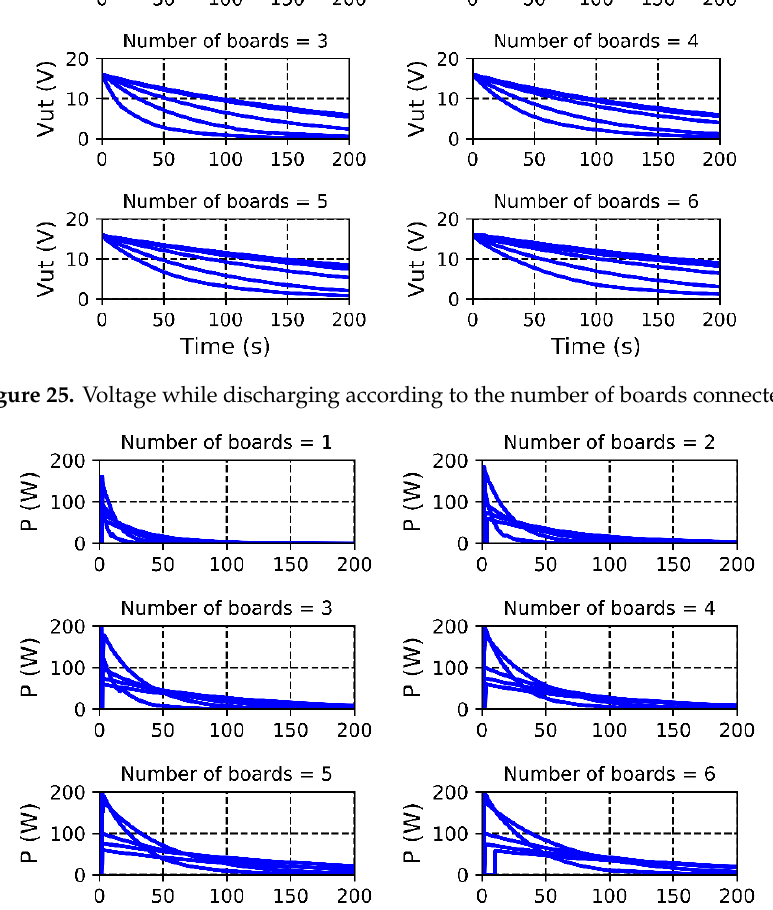
Figure 26. Power while discharging according to the number of boards connected.